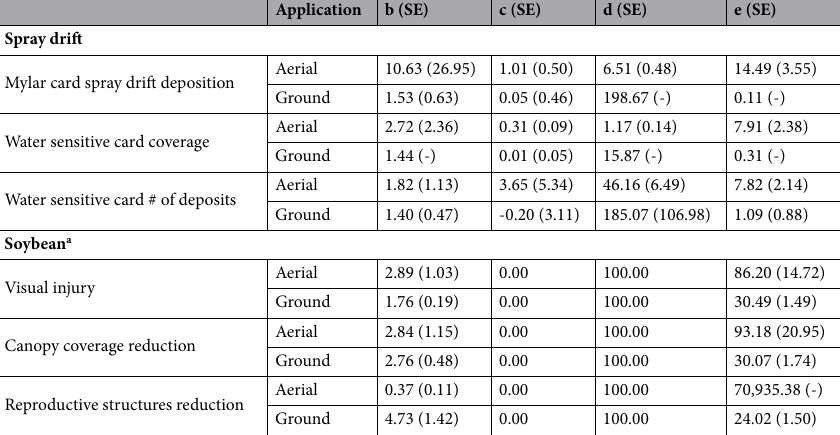
Table 1. Parameter estimates for four parameter log-logistic regressions used to model spray drift and resulting soybean response from ground and aerial applications of florpyrauxifen-benzyl. a Parameters “c” and “d” were fixed at 0 and 100, respectively, for soybean measurements as all data were bound between 0 and